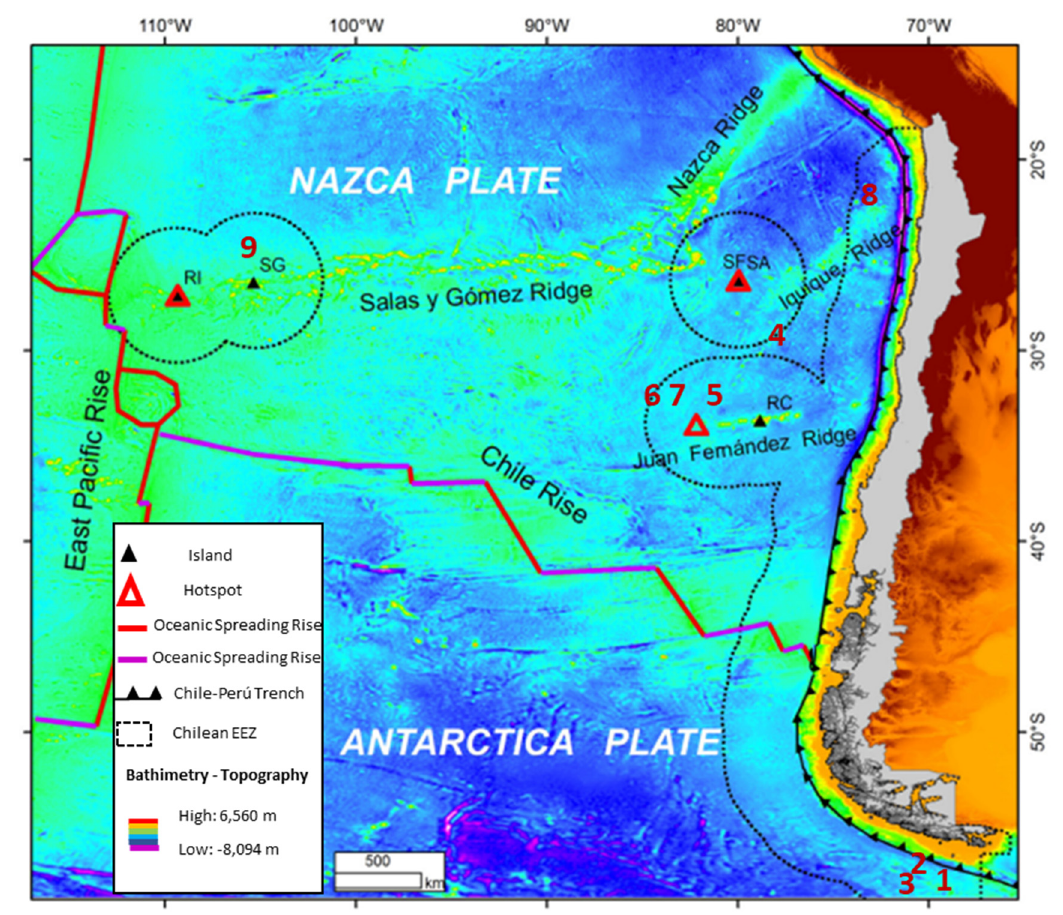
Figure 4. Islands with potential mineral resources to be exploited in the Chilean EEZ. RC: Robinson Crusoe Osland; SF: San F é lix Island; SA: San Ambrosio Island; RI: Rapanui Island; SG: Salas y G ó mez Osland; AS: Alejandro Selkirk Island (adapted from Garc í a et al.